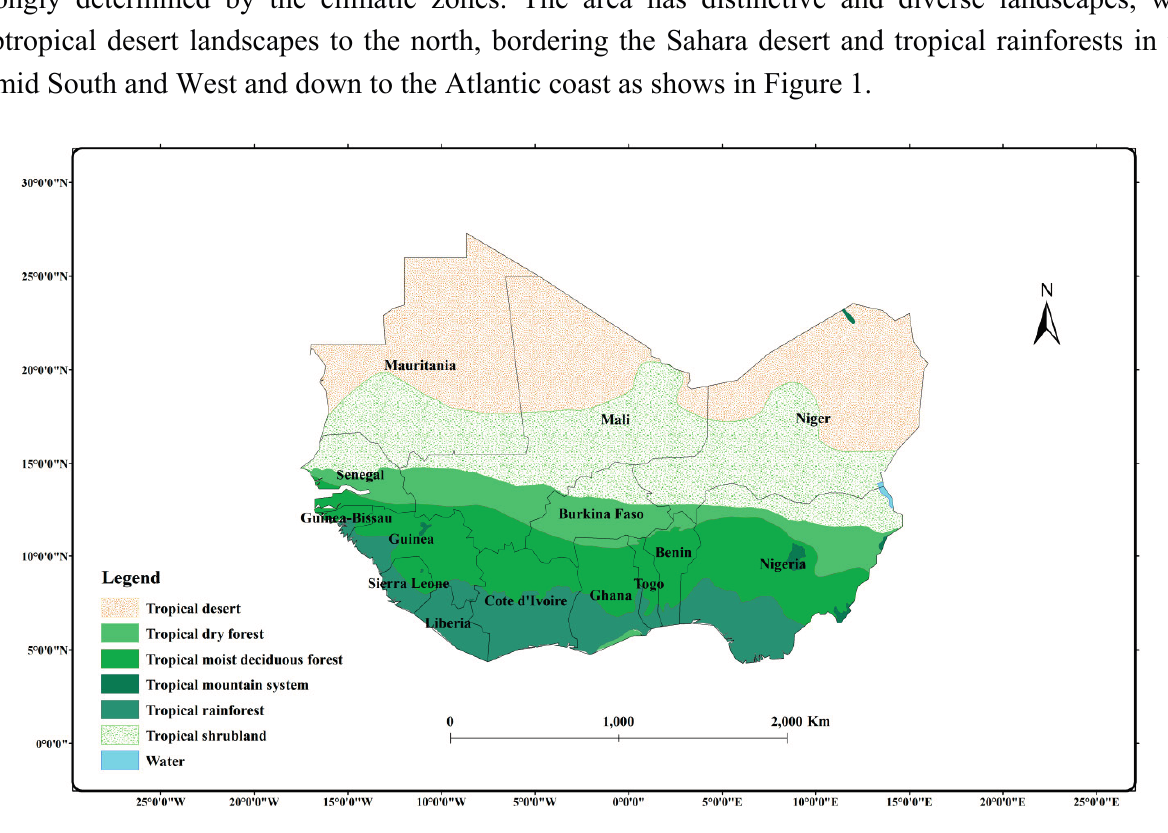
Figure 1. The ecological regions of West Africa (data source